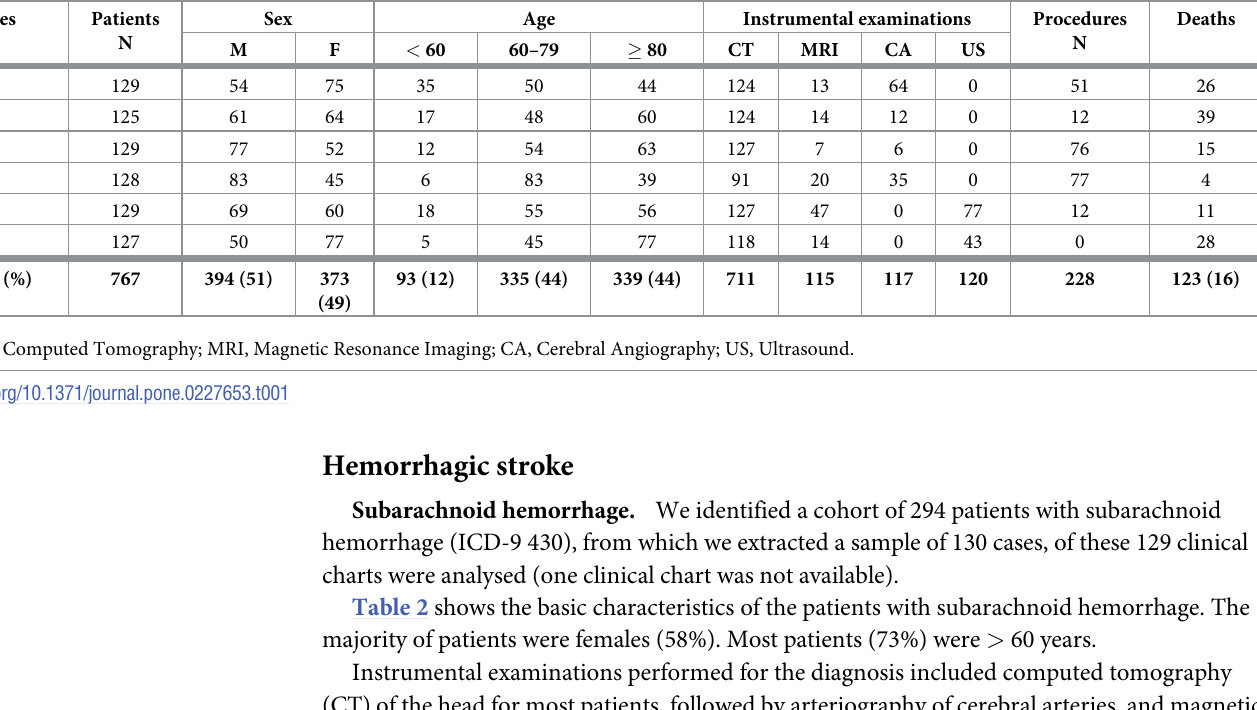
Table 1. Characteristics of the overall study sample. ICD-9 codes